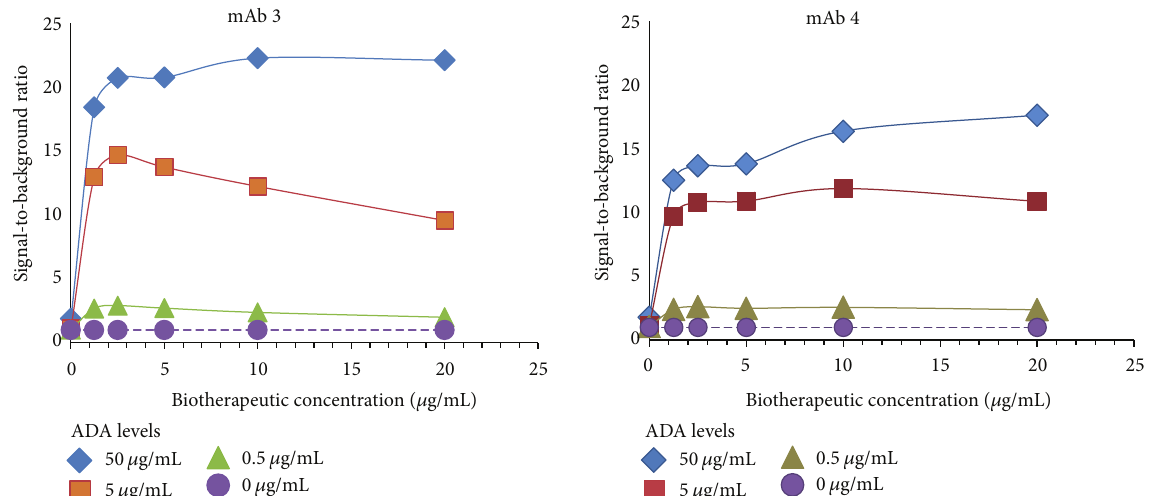
Figure 2: The same concentration of biotherapeutic can be used with different biotherapeutics to form complexes with ADA. Signal-to- background ratios obtained in a pooled cynomolgus monkey serum spiked with purified cynomolgus monkey anti-human IgG ADAs at 0 to 50 𝜇 g/mL and with 8 biotherapeutics at 0 to 20 𝜇 g/mL. The biotherapeutics consisted of 4 ADCs, 3 mAbs, and a one-arm antibody. With all the biotherapeutics, the signal-to-background ratios increased with increasing concentrations of ADA to reach a plateau at biotherapeutic concentrations between 2 and 10 𝜇 g/mL. Based on these data, a biotherapeutic concentration of 5 𝜇 g/mL in neat serum was determined to be appropriate to form complexes with ADA in the samples containing up to 50 𝜇 g/mL of ADA, the highest level tested in our study. ADAs = anti-drug antibodies; ADC = antibody-drug conjugate; mAb = monoclonal antibody.